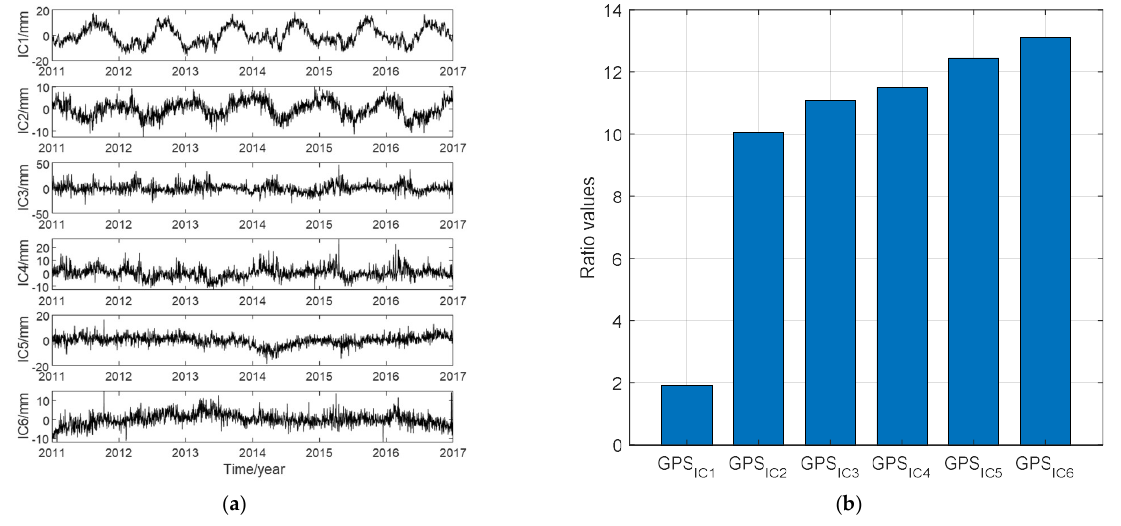
Figure 4. ( a ) The top six ICs extracted from vertical GPS coordinate time series; ( b ) the ratio value of each displacement GPS ICs.